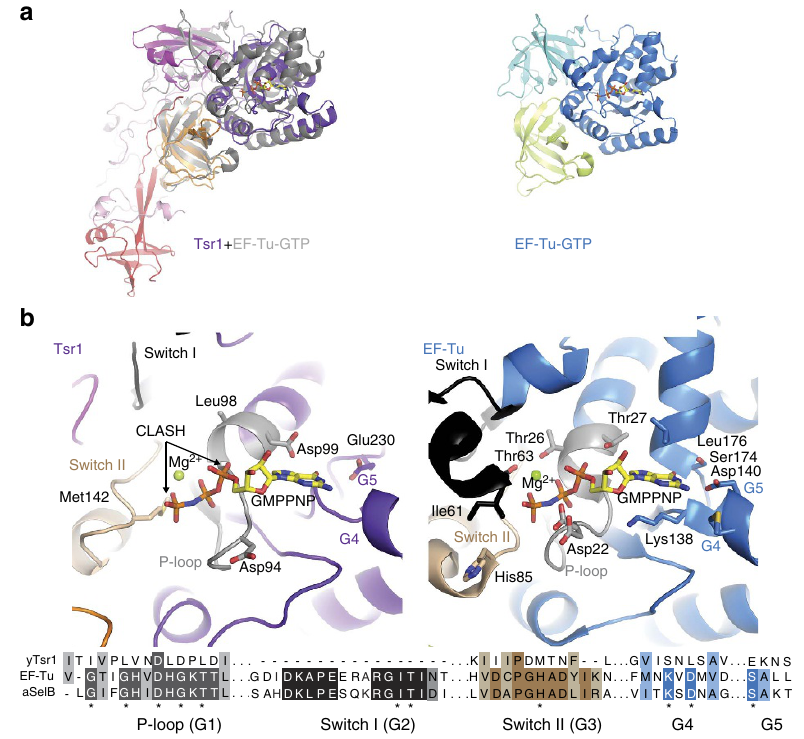
Figure 2 | Tsr1 lacks a functional GTPase active site. ( a ) Comparison of Tsr1 with the crystal structure of EF-Tu in the GTP-bound state (PDBid 1exm). A cartoon representation of Tsr1 is shown superposed with EF-Tu in grey on the left, while a cartoon structure of EF-Tu is shown in the same orientation on the right. EF-Tu domains I–III are coloured blue, teal and green, respectively. The GTP analogue GMPPNP is shown as sticks. ( b ) A close-up view of the active site of EF-Tu (right) and the equivalent site of Tsr1 with GMPPNP from EF-Tu superposed. Clashes between GMPPNP and Tsr1 are indicated with arrows (left). Sequences for characteristic motifs of GTPases are shown underneath, derived from a structure-based sequence alignment. In both sequence and structures, switch I is black, switch II is wheat and the P-loop is grey.